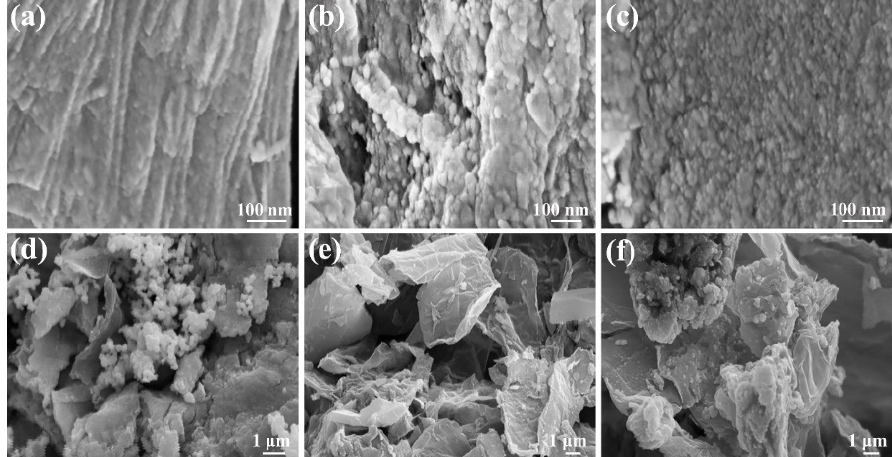
Figure 4. HRSEM images of ( a ) GO–Ag NPs, ( b ) GO–Cu NPs, ( c ) GO–Pt NPs, ( d ) GO/Ag/DBSA–PANI, ( e ) GO/Cu/DBSA–PANI, and ( f ) GO/Pt/DBSA–PANI.